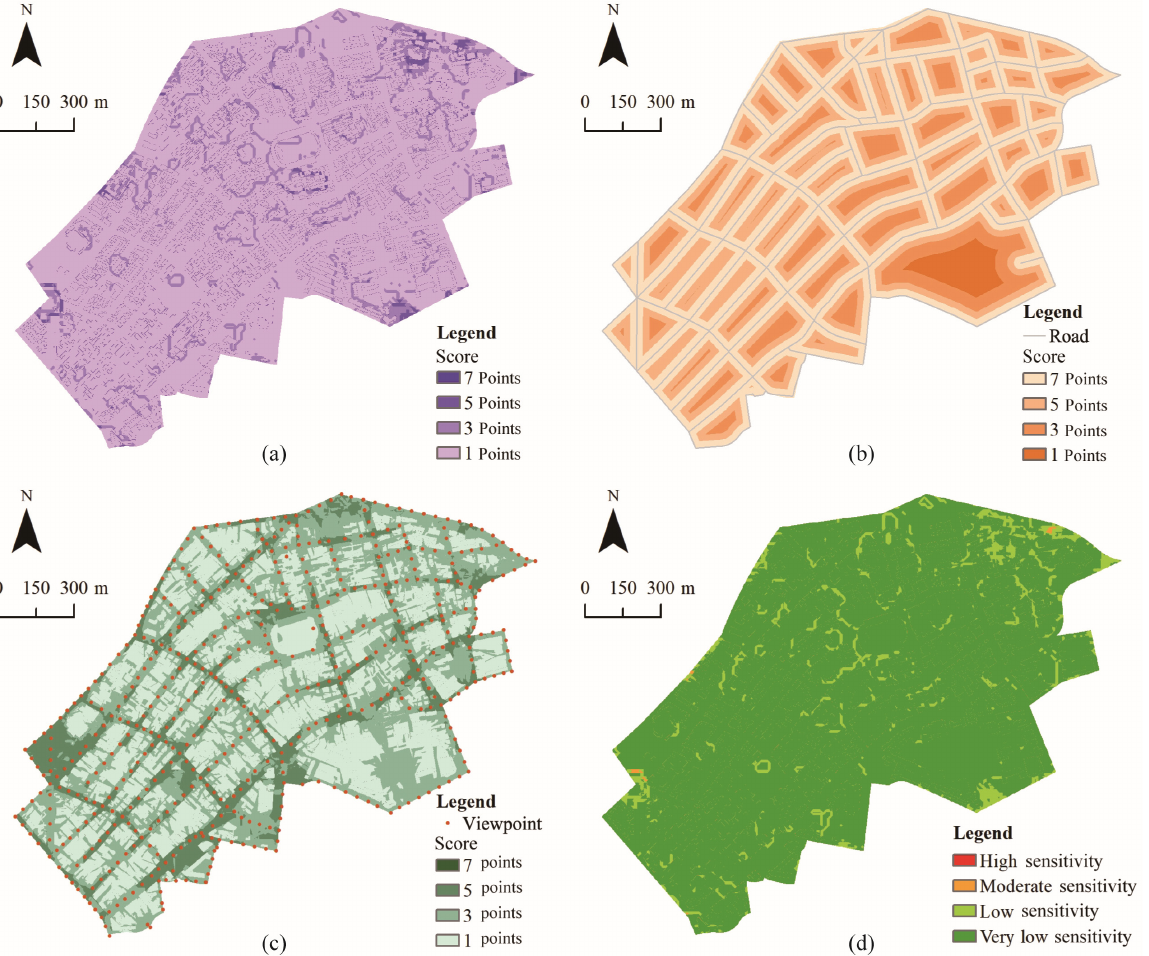
Figure 5. The visual sensitivity based on visibility: ( a ) relative slope-based sensitivity criterion; ( b ) relative distance-based sensitivity criterion; ( c ) visual probability-based sensitivity criterion; ( d ) classification and distribution of visibility visual sensitivity.